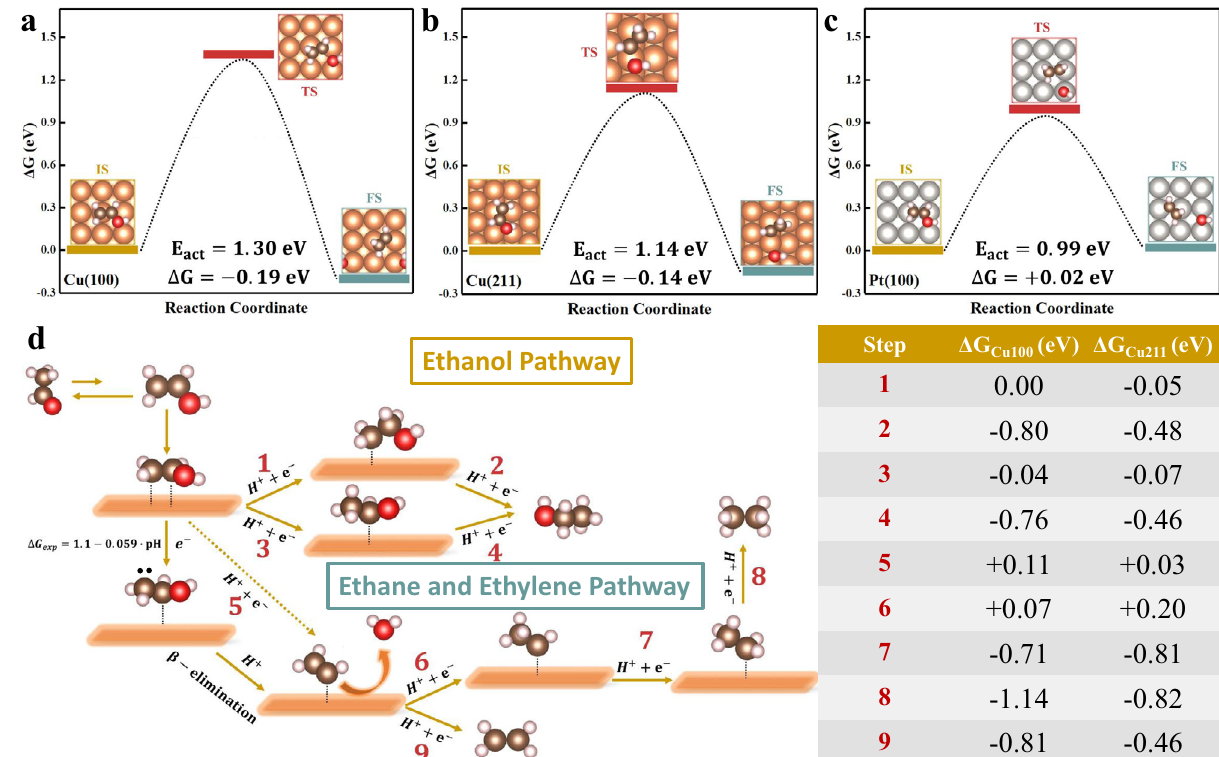
ethylene,ethane,andethanolonCu(100)andCu(211).All Δ G valuesaregivenat0V vs.RHEbased onCHEmodel.Solidarrowsindicateproposed pathwayanddashed arrow denotes unlikely pathway. Color code: hydrogen in white, oxygen in red, carbon in brown, copper in orange, platinum in